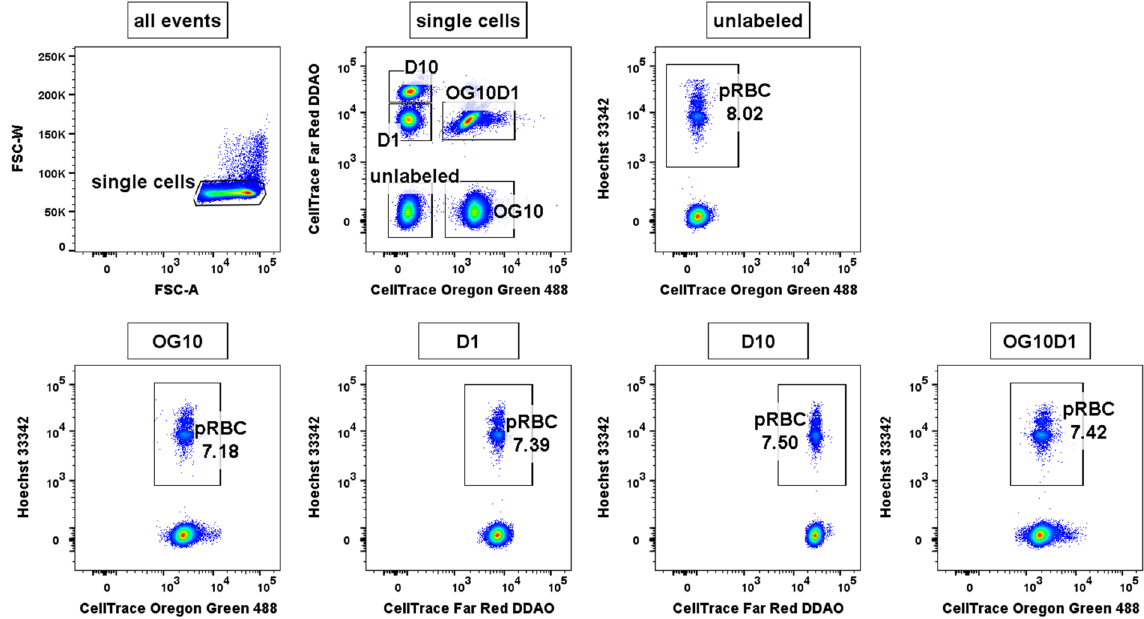
Figure 3. Example gating scheme to determine parasitemia in labelled and unlabelled erythrocytes. Erythrocytes labelled with 1 or 10 µ M of DDAO, 10 µ M of OG or a combination of both were mixed and incubated with P. falciparum parasites for 48 h to allow rupture of schizonts and subsequent invasion of labelled and unlabelled erythrocytes. The cells were then stained with Hoechst 33342 and analyzed by flow